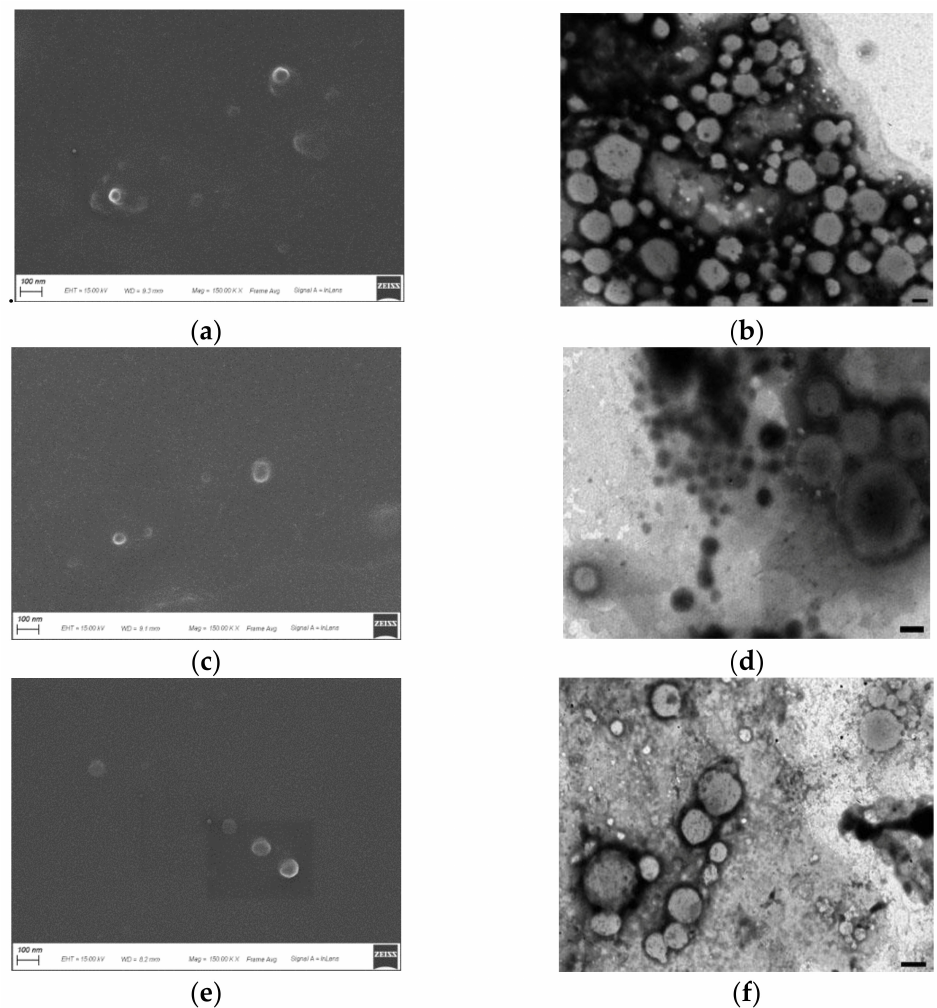
Figure 5. SEM and TEM imaging of NanoS cross-linked by different times: ( a ) SEM of NanoS_24; ( b ) TEM of NanoS_24; ( c ) SEM of NanoS_48; ( d ) TEM of NanoS_48; ( e ) SEM of NanoS_72; ( f ) TEM of NanoS_72 ( b , d , f scale bar = 100